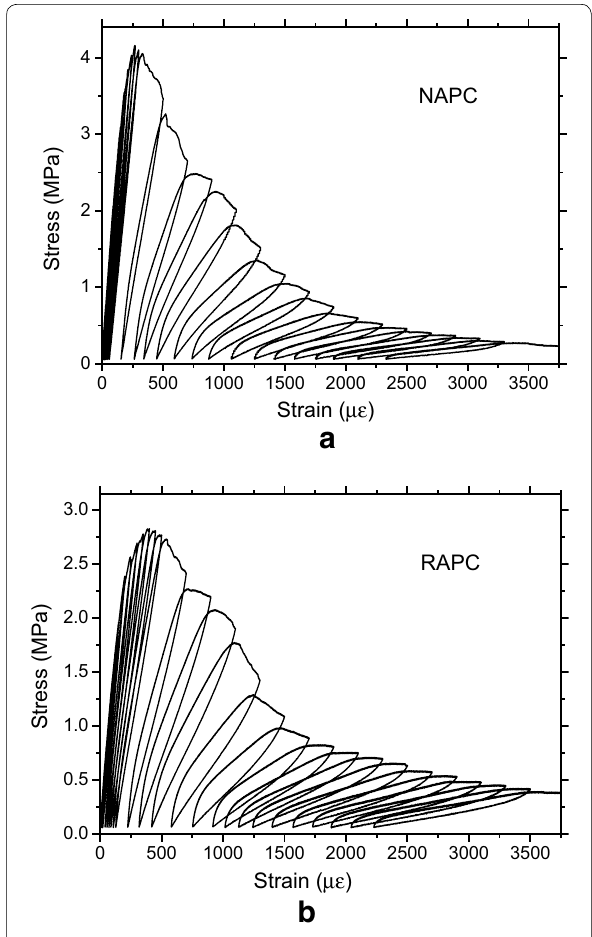
Fig. 10 Stress-strain curves during loading–unloading process for pervious concrete: a NAPC and b RAPC.